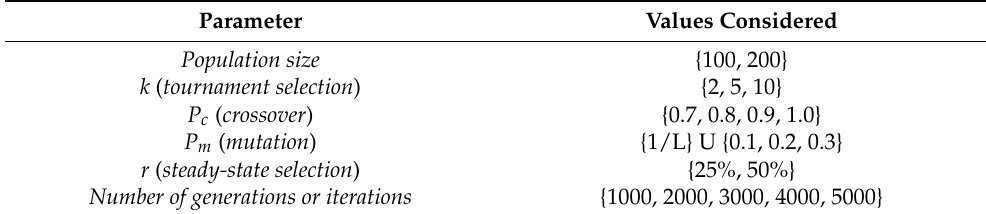
Table 3. Parameter settings considered in the preliminary experiments. Parameter Values